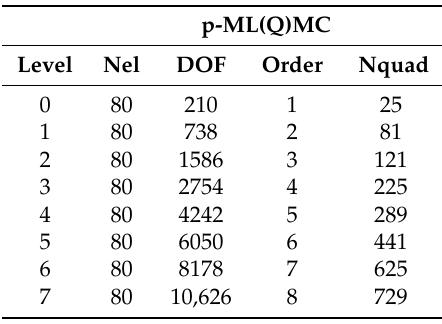
Table 3. Number of elements, degrees of freedom, element order and number of quadrature points for model problem 1 for additional